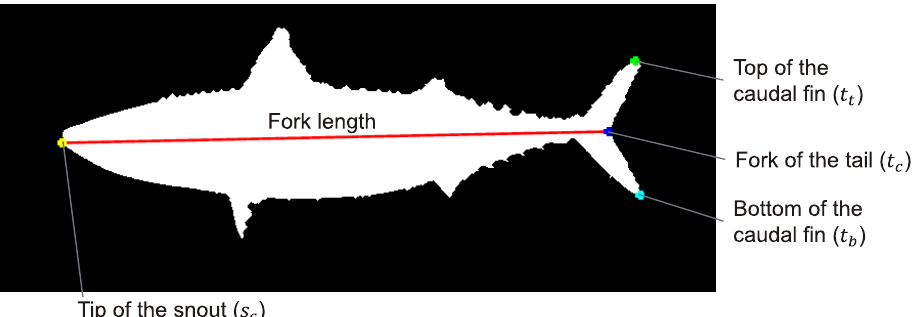
Figure 6. Feature points used for measuring fork